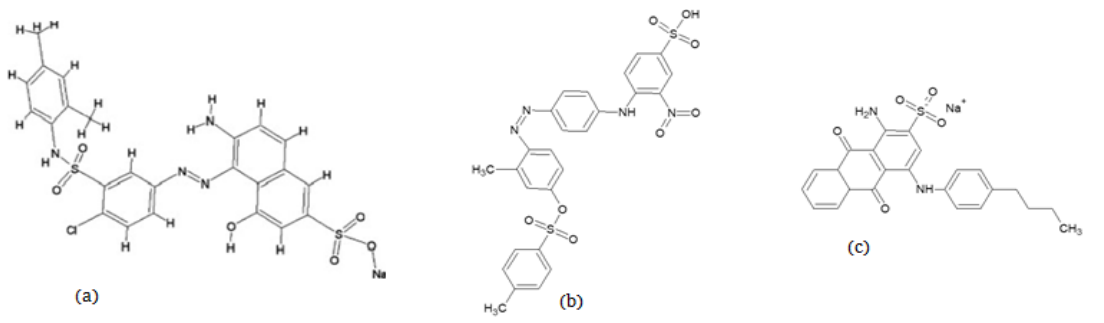
Figure 1. Structure of three Nylosan N acid dyes: ( a ) Red Nylosan N-2RBL; ( b ) Yellow Nylosan N-3RL and ( c ) Acid Blue 230, one of the Blue Nylosan N-GL constituents. Table 1. Composition of the dyeing bath utilized in the dyeing process. Constituents